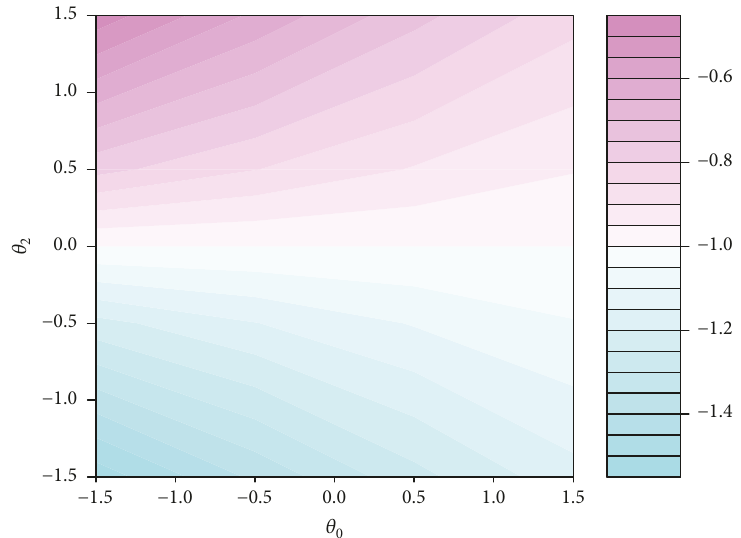
Figure 1: Contour plot of 𝛽 ∗ 3 under